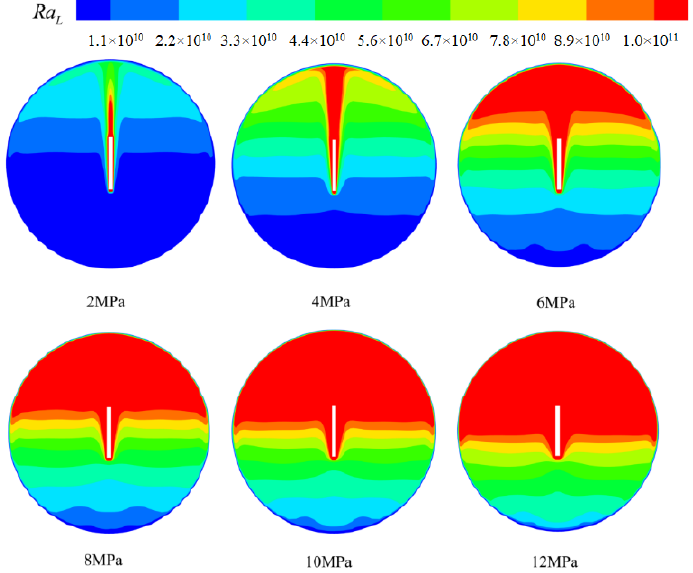
Figure 10. Distribution of the local Rayleigh number under different conditions (heating power: 10 W, Ra L range: 10 10 − 10 11 ).